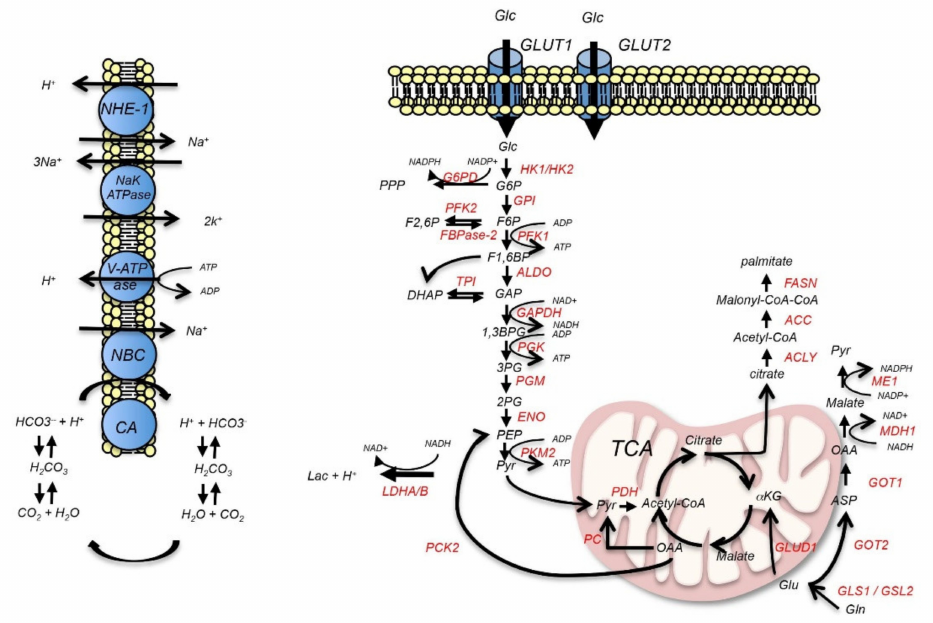
Figure 7. Schematic illustration of the e ff ects of PKC activation on metabolic and transport metabolon proteins. After PMA-stimulation, PKC induces the up-regulation of LDHA and HK2. This is associated with an increased expression of sodium bicarbonate cotransporter 3 (NBCn1). Here, we also report